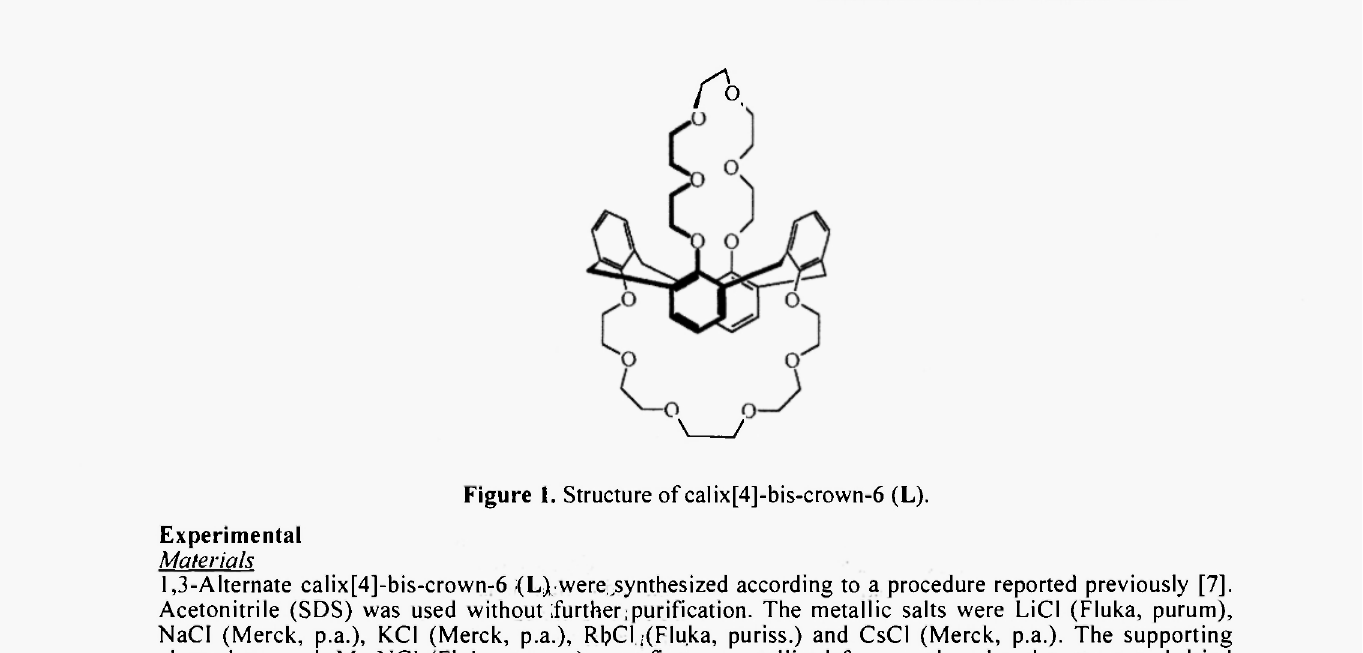
Figure 1. Structure of calix[4]-bis-crown-6